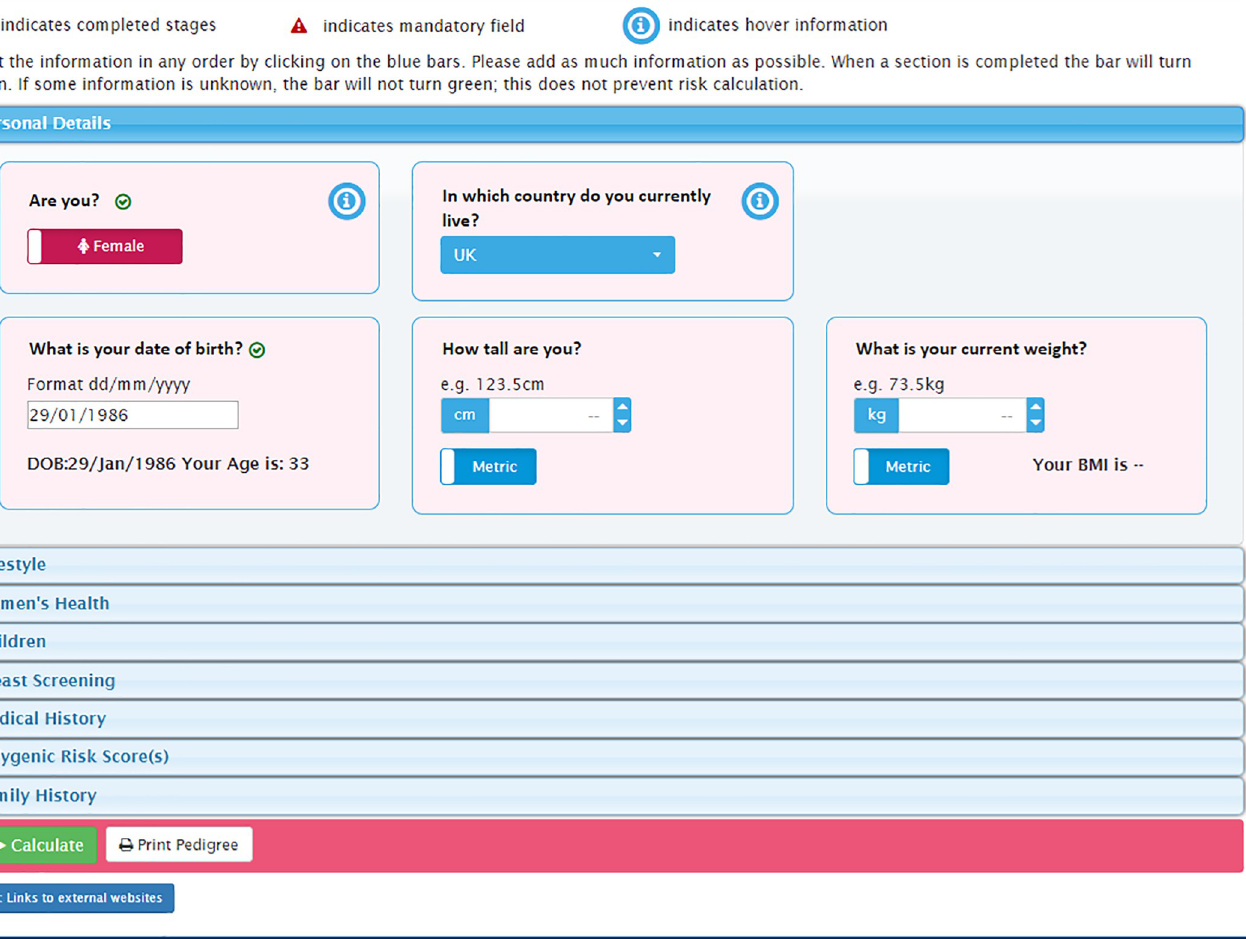
PLOS ONE | https://doi.org/10.1371/journal.pone.0229999 March 6,